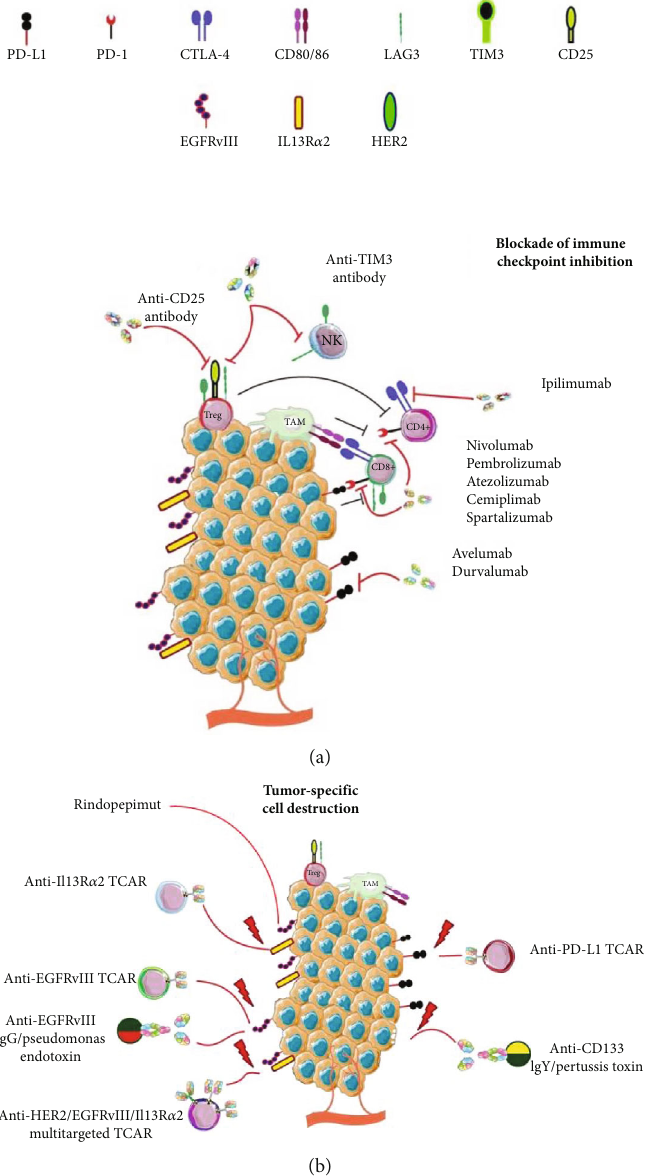
Figure 2: The immunotherapeutic approaches on GBM. (a) Monoclonal antibodies and their targets on the GBM microenvironment are aimed at blocking the circuit of proliferative signals in the tumor cells or restoring antitumor immune responses by blocking immune checkpoint signalling, inhibiting Treg populations, or stimulating cytotoxic lymphocytes. (b) CAR-Ts and immunotoxins designed for the recognition and elimination of malignant cells based on the expression of tumor-associated antigens present on GBM